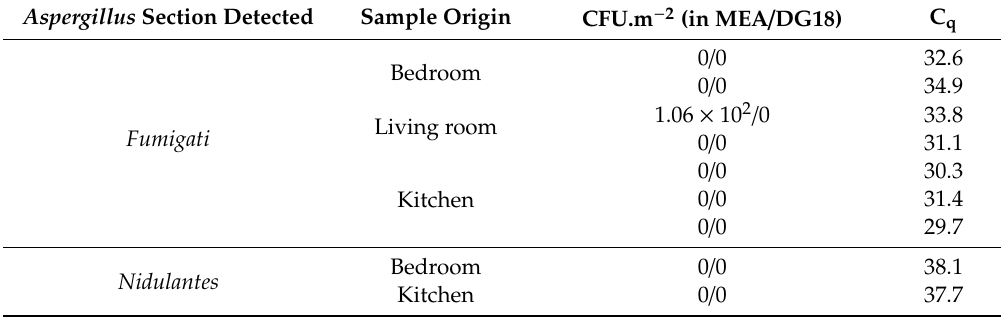
Table 9. Molecular detection of Aspergillus sections Fumigati and Nidulantes . Aspergillus Section